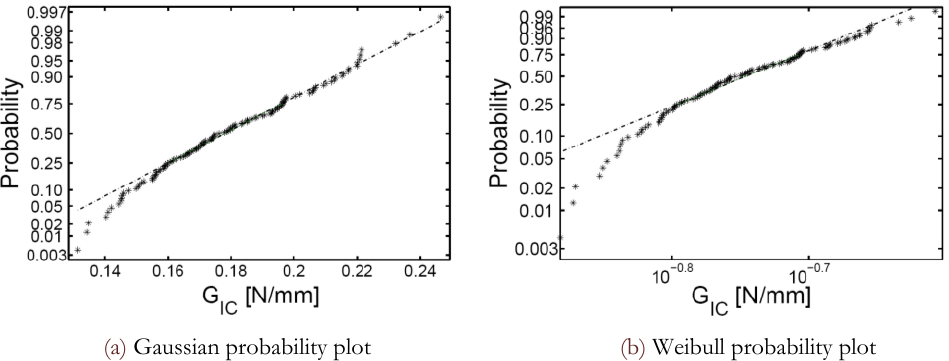
Figure 7: Mode I interface fracture energy distribution and comparison with the Gaussian and the Weibull